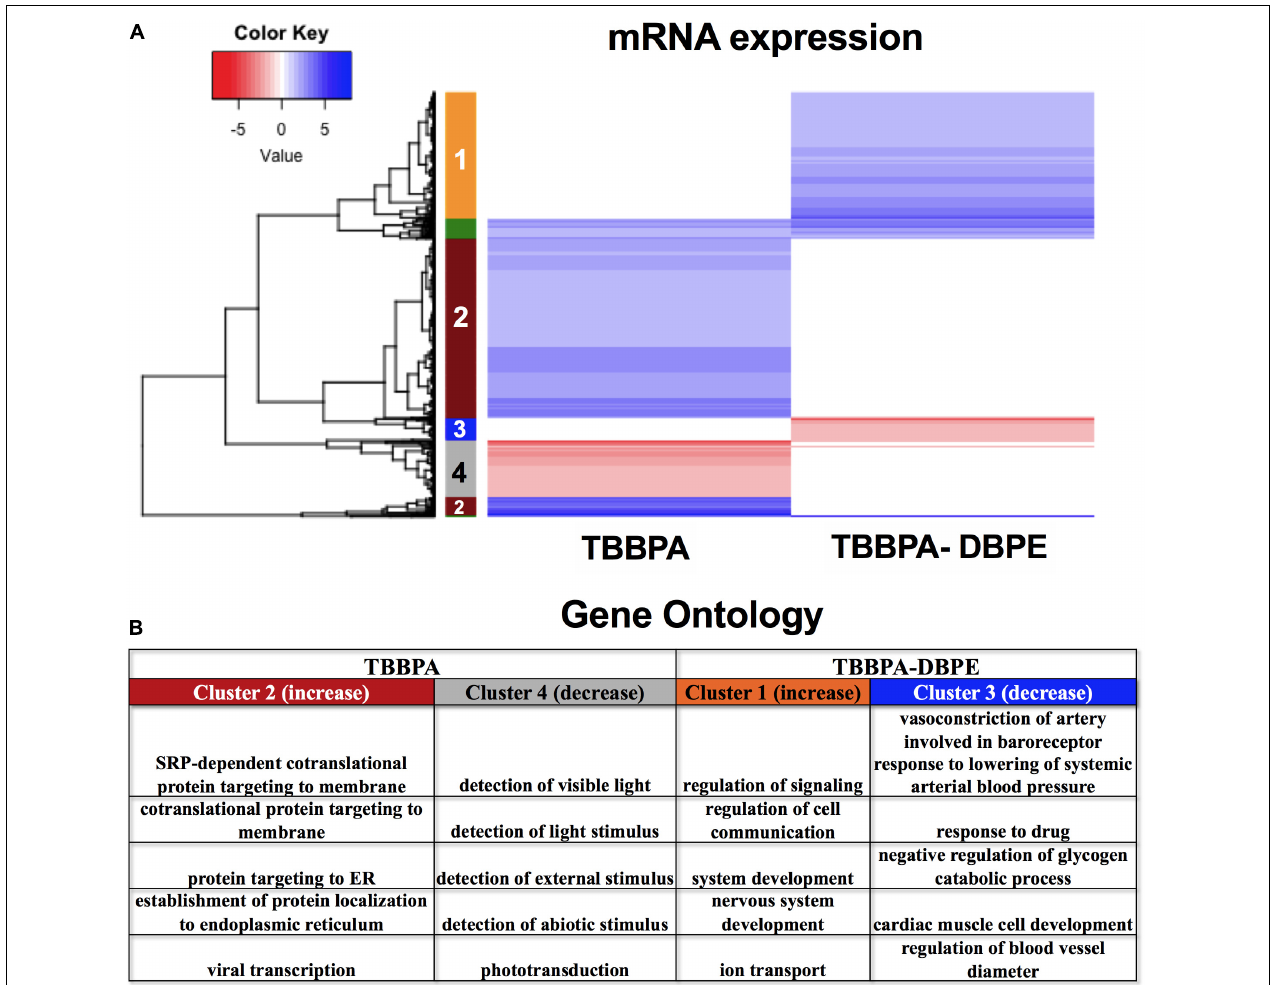
FIGURE 9 | mRNA expression for TBBPA vs its derivative, TBBPA-DBPE. (A) Heatmap representing log 2 fold changes of mRNA expression; colored bars on the rows represent gene clusters. Numbers within bars represent cluster numbers for specific mRNA sets. (B) GO processes for unique mRNAs that were increased or decreased uniquely in either